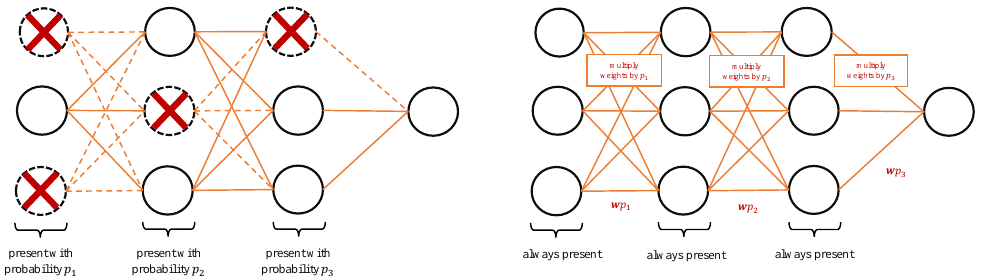
Figure 1. Dropout during the training ( left ) and testing phase ( right